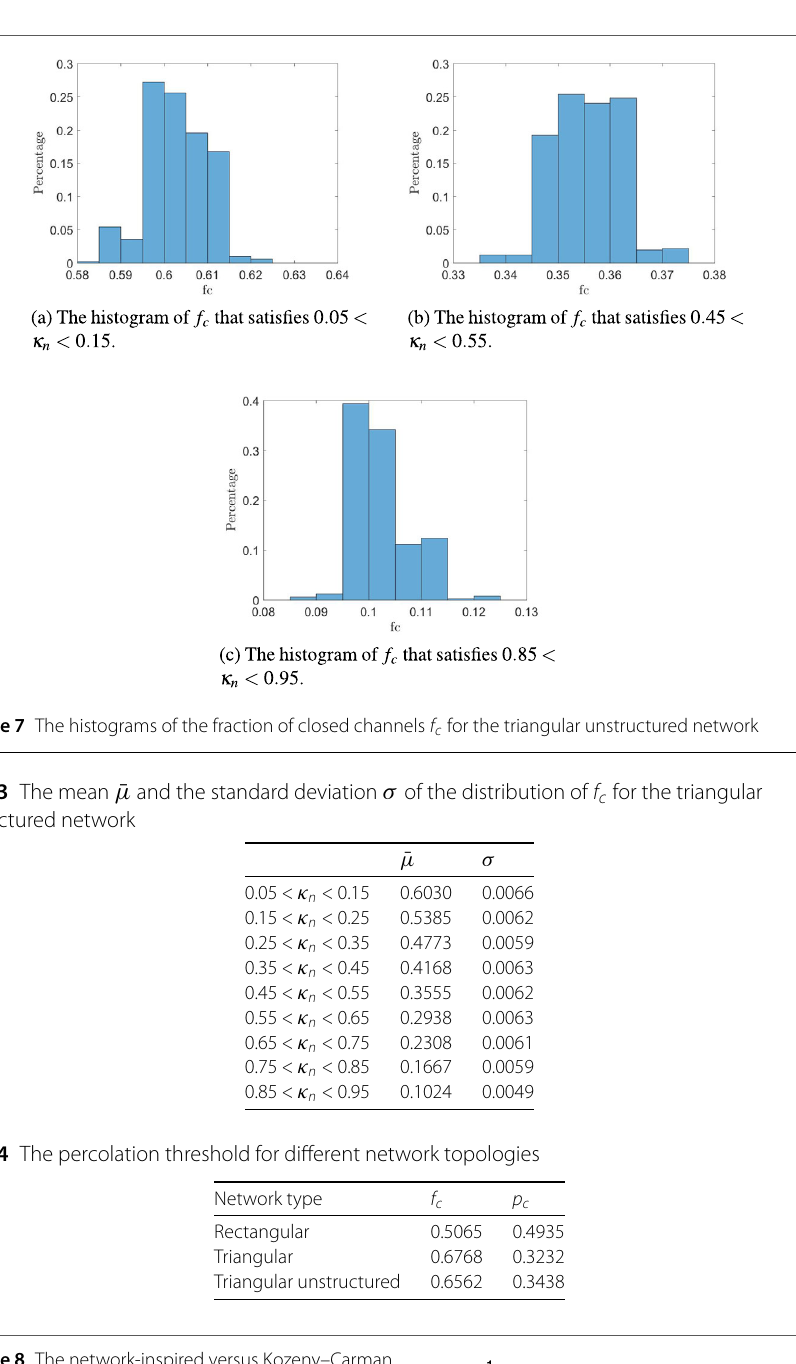
Figure 8 The network-inspired versus Kozeny–Carman based permeability-porosity